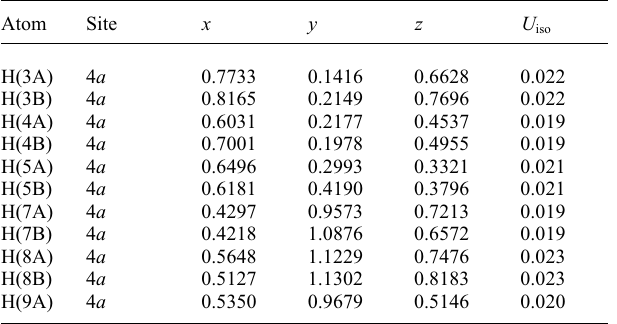
Table 3. Atomic coordinates and displacement parameters (in Å 2 )